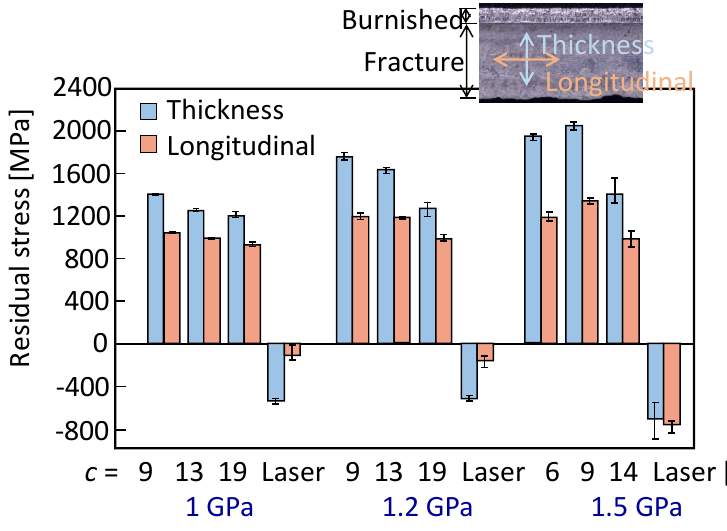
Figure 12. Residual stress at the middle of the fracture surface of sheared edges of cold-blanked ultra-high strength steel sheets [66].